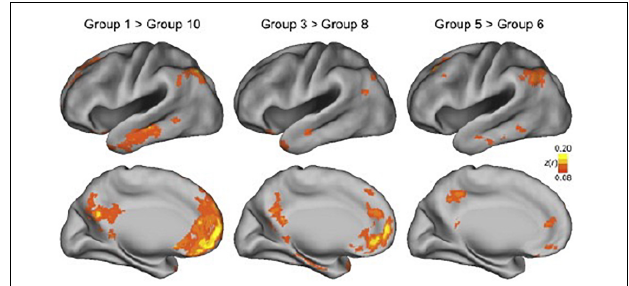
FIGURE 3 | Effect of movement on connectivity maps. In this study, functional networks were estimated for groups of ∼ 100 participants each. The groups were created by ranking participants by head motion, with group 1 containing the 100 participants with the least movement and group 10 containing the 100 participants having the most movement. The top panels show the lateral view of the cerebral cortex, while the bottom panels show the medial view. The superimposed blobs indicate significant connectivity differences. The color indicates the z-value of the difference in connectivity estimates, with yellow indicating a greater difference and orange/red a smaller difference. The two maps on the left show the difference between the bottom 10 percentile (participants that moved least) and the top 10 percentile (participants that moved most). The middle and right panels also show differences between deciles, but progressively closer to each other in terms of movement. As can be seen, for large areas in the temporal, medial parietal, and medial frontal lobes, connectivity estimates are affected by movement. This figure also demonstrates that all comparisons show differences in connectivity estimates, even in the two most adjacent groups in the panel on the right. Reproduced from Van Dijk et al. (2012).